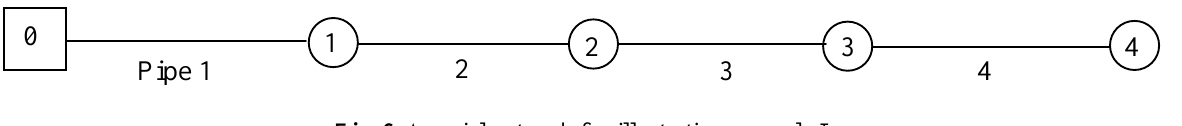
Fig. 6. A serial network for illustrative example I. Table 2. Comparison of results of indirect approaches for illustrative example